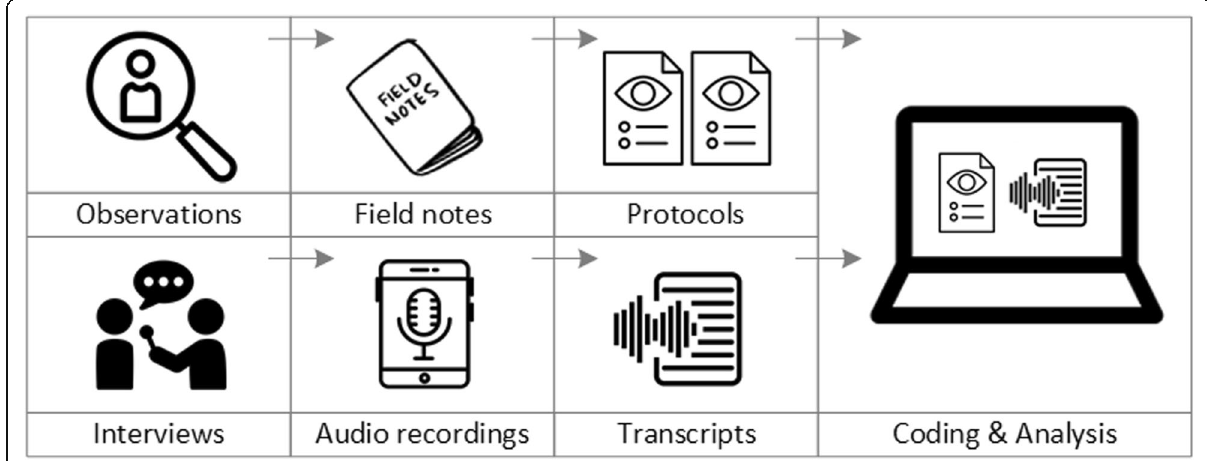
Fig. 3 From data collection to data